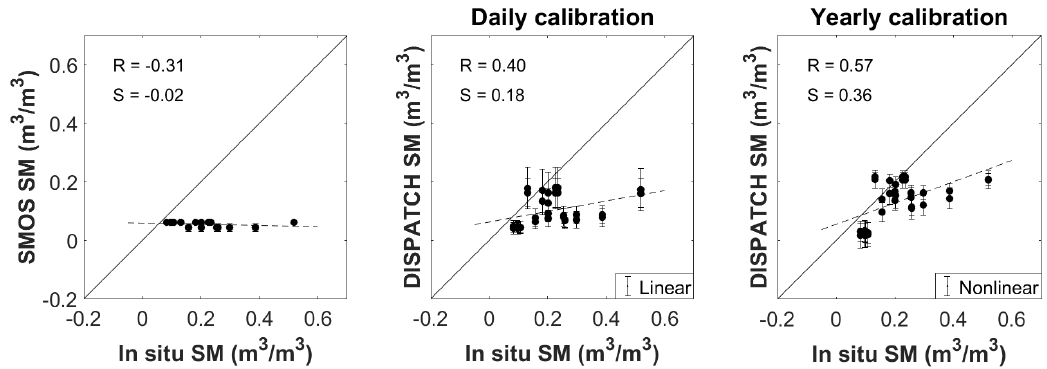
Figure 5. The SMOS and DISPATCH SM are plotted against 1 km aggregated Urgell in situ measurements for DOY 223 (year 2015). The correlation coefficient (R) and slope of linear regression (S) are also shown in each